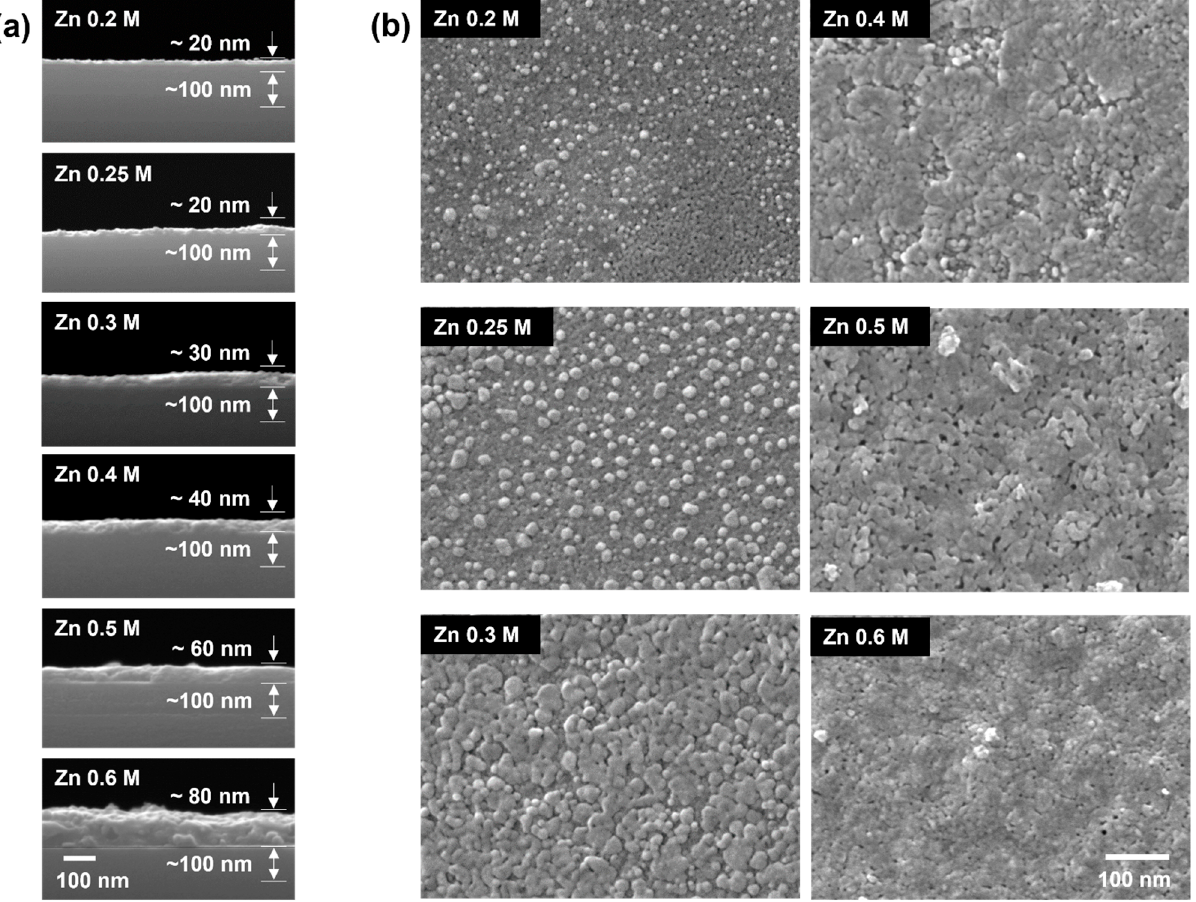
Figure 2. ( a ) Cross-section and ( b ) morphological SEM images of a -IZO films with respect to the Zn molarity ratio. The In molarity ratio used for the fabrication of each a -IZO film was 0.05 M. To determine the crystallinity characteristics, the XRD patterns of the fabricated a -